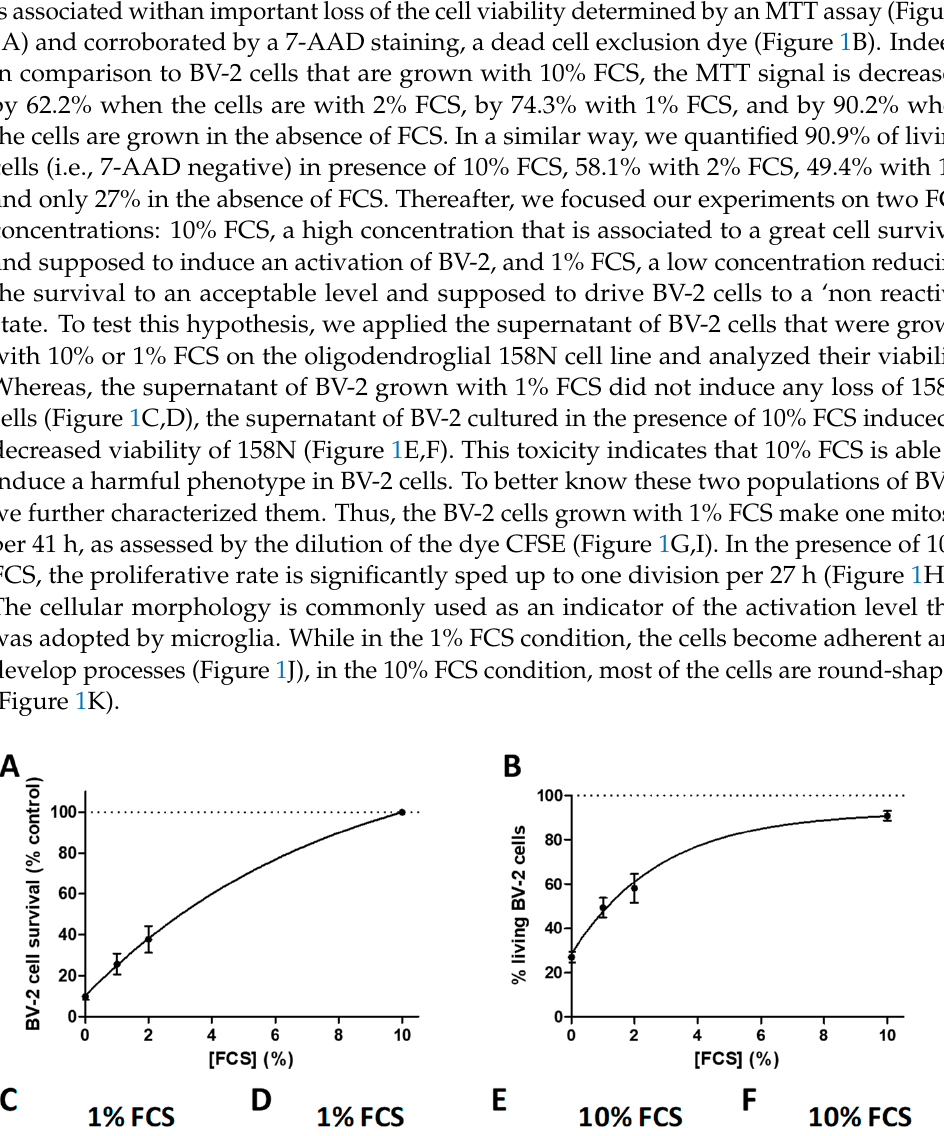
Figure 1. Variations of serum concentrations affect the viability and differentiation of BV-2 cells. ( A ) The viability of BV-2 cells grown in presence of different serum concentrations was assessed by a MTT assay and corroborated ( B ) with a 7-AAD viability staining measured by flow cytometry. ( C , D ) The supernatant of BV-2 grown in a low concentration of serum (1% Fetal Calf Serum (FCS)) does not modify the survival of 158N oligodendrocyte cell line, whereas ( E , F ) the supernatant of BV-2 grown in a high concentration of serum (10% FCS) reduced significantly the survival of 158N cells. ( G – I ) The Carboxyfluorescein Diacetate Succinimidyl Ester (CFSE) dilution was used to determine the proliferation rate of the BV-2 cells. The CFSE dilution was followed day by day by flow cytom- etry in the culture condition ( G ) 1% FCS or ( H ) 10% FCS. D: day. ( I ) Determination of the number of cell divisions showed that the proliferation of BV-2 cells is reduced in presence of a low concen- tration of serum. ( J ) Whereas, in the presence of a low concentration of serum (1% FCS), the BV-2 cells adopted an elongated morphology, ( K ) they exhibited a rounded shape in presence of a high concentration of serum (10% FCS). Mean values ± SEM are shown, from n = 3–4 independent exper- iments, * p < 0.05, ** p < 0.01.